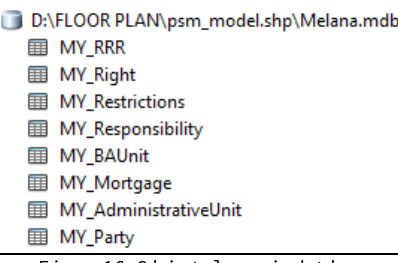
Figure 16. Object classes in